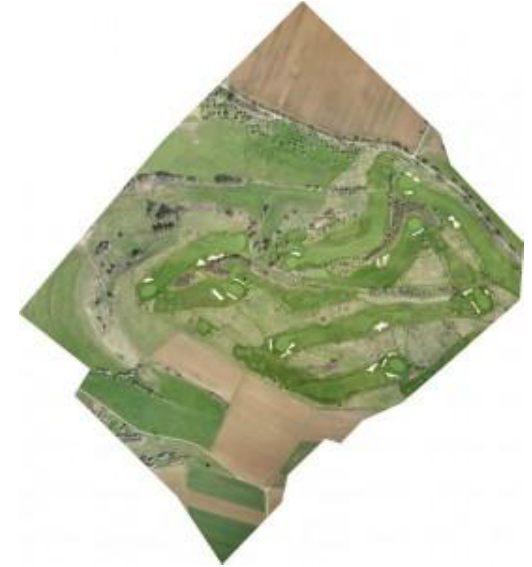
Figure 6 Golf course Hechingen, Germany Example 2 is a metro station in northern Germany. The train